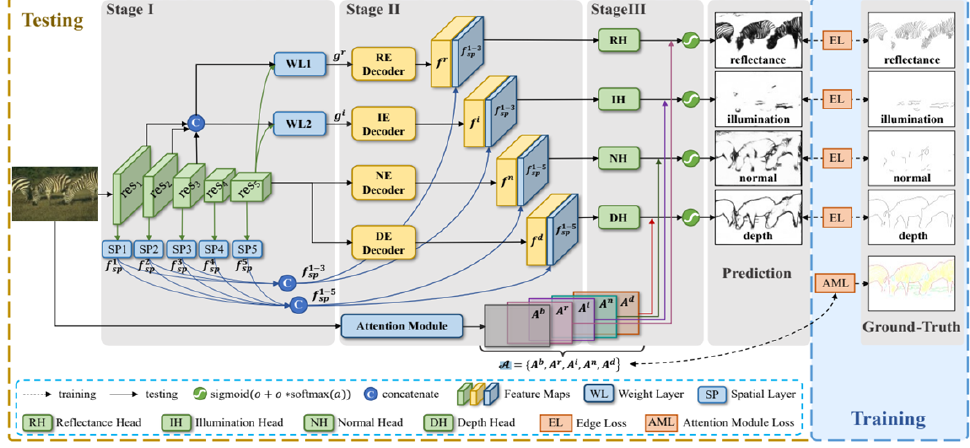
Figure 1. Architecture of RINDNET (from